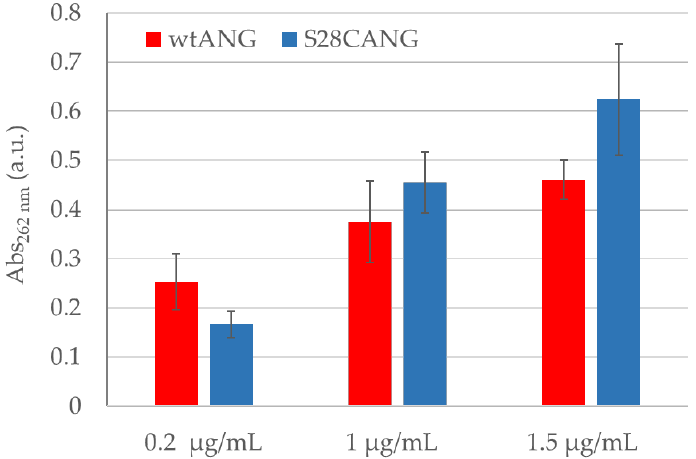
Figure 1. Ribonucleolytic activity of wtANG and S28CANG. Assay was performed at increasing protein concentration (0.2, 0.5, 1, 1.5 μg/mL), in 33 mM MOPS buffer, at 37 °C for 2 h, with the addition of 6 × 10 2 μg/mL tRNA. Averaged values and standard deviation from three experiments.